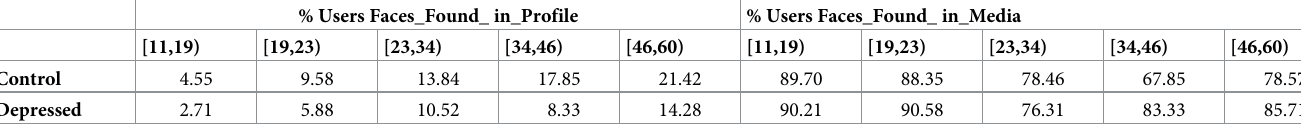
Table 7. Facial presentation distribution for different age group(in years old) in profile and